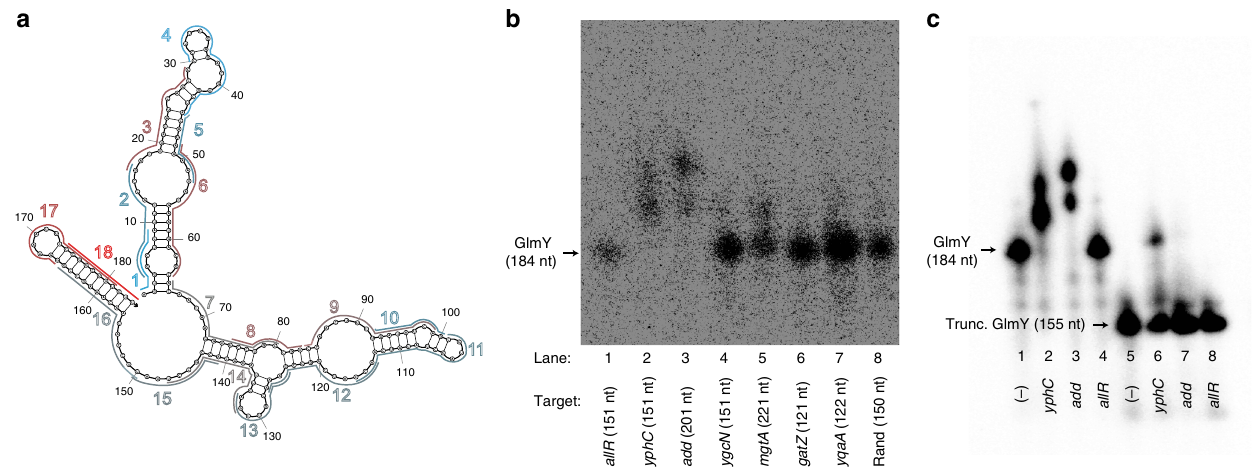
Fig. 6 INTERFACE pinpoints mRNA regulation in the GlmY terminator region. a Regions 17 and 18 within the GlmY terminator exhibit drastically high accessibility compared to all other regions probed for accessibility within the sRNA. Pictured minimum free energy secondary structure was predicted via Nupack 78 . b Seven mRNAs were tested for interaction with GlmY based on computational predictions implicating at least fi ve nucleotides of the accessible terminator regions in target binding. Importantly, allR and yphC were selected from IntaRNA predictions of the INTERFACE – accessible terminator sequence alone as the query RNA input. Two strong targets are observed: yphC and add . c Binding assays of the two con fi rmed strong targets as well as a negative control ( allR ) were performed with full-length GlmY as well as a truncated version, in which all nucleotides downstream of the fi rst basepair in the terminator stem were excised. Con fi rmed target binding to GlmY is diminished in the absence of the